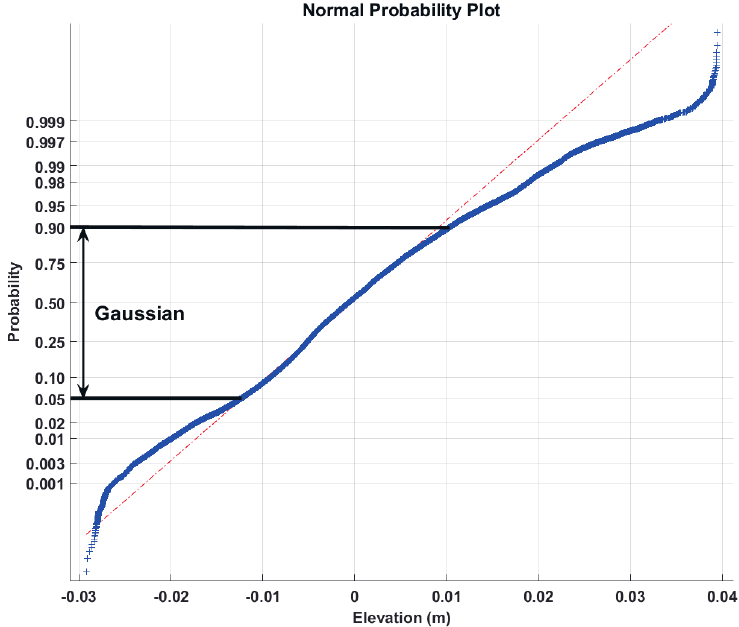
Figure 9. A probability plot of elevation data from site 4. The normal distribution is shown as the dotted-dashed